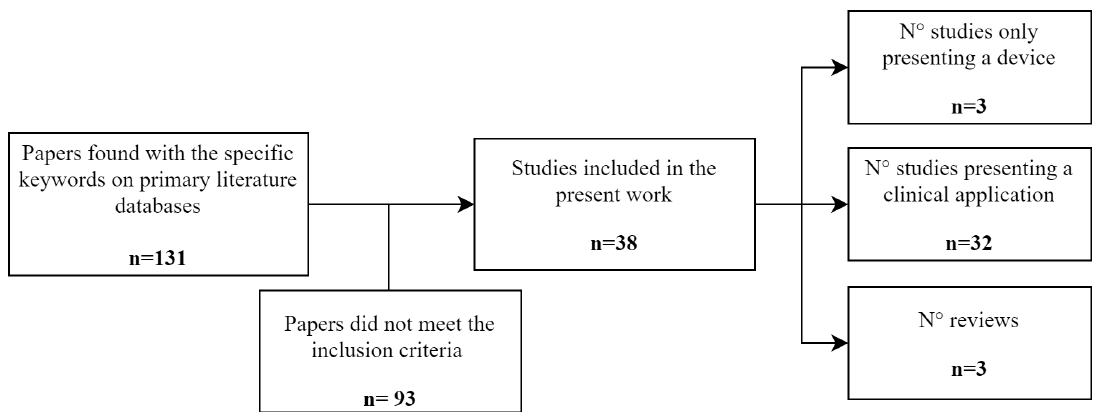
Figure 1. The flow diagram of the number of studies